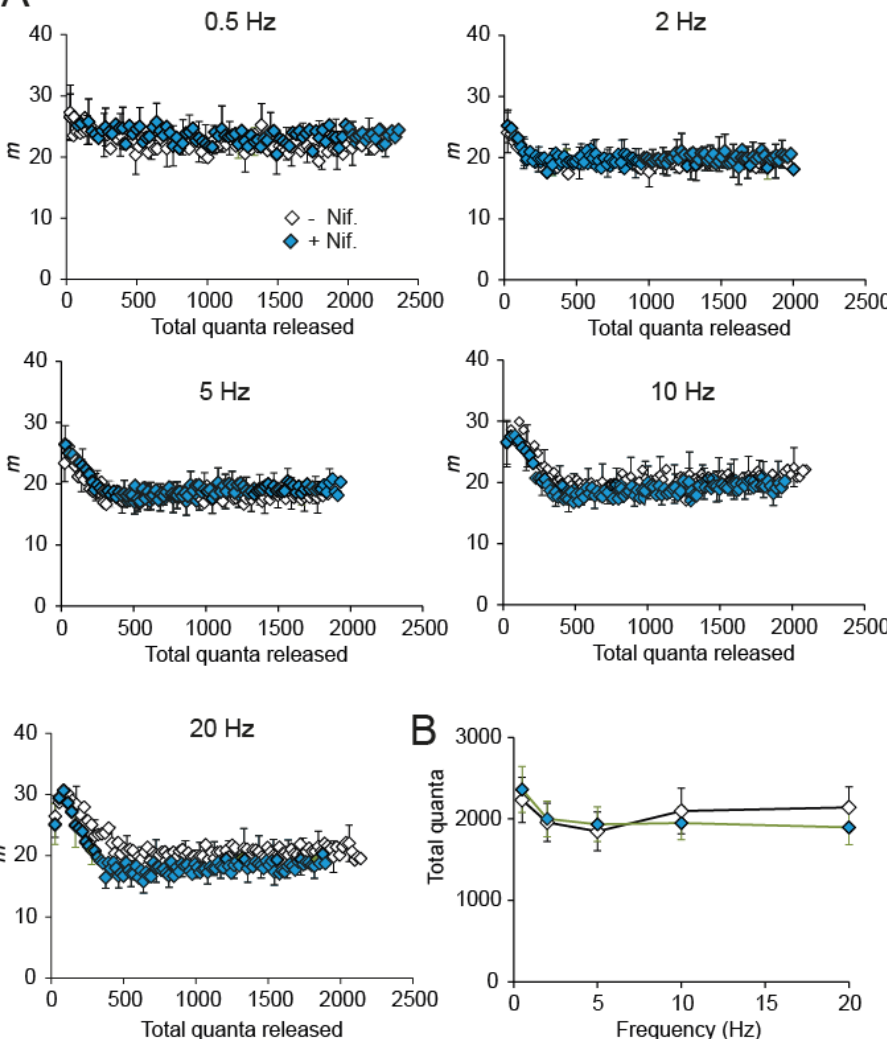
Figure 5. Evoked release in adult motor nerve terminals is insensitive to nifedipine. ( A ) Average quantal releases during trains of 0.5–20 Hz were indistinguishable without (black symbols) or with (green symbols) nifedipine. ( B ) Plot of the average quanta released during 100 shocks versus stimulation frequency in the absence and the presence of nifedipine.